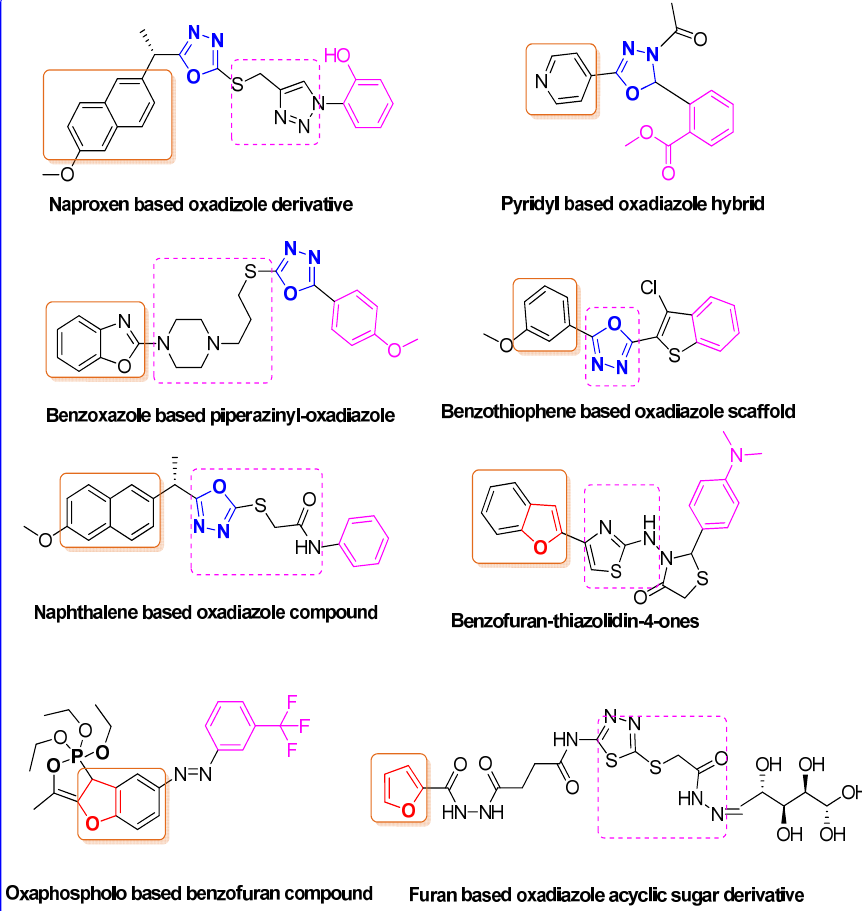
Figure 3. The most active furanand oxadiazole core-based anti-HepG-2